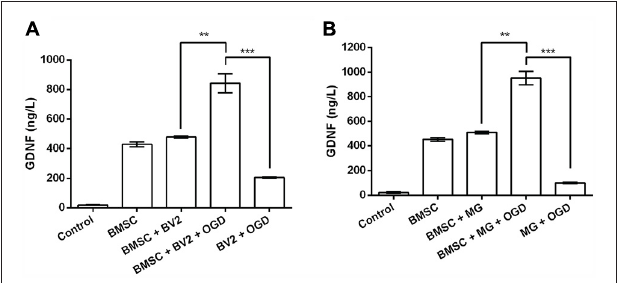
FIGURE 1 | Conditioned medium (CM) from cultures of oxygen-glucose deprivation (OGD) activated BV2 and microglia (MG) stimulates glial cell-derived neurotrophic factor (GDNF) production by bone marrow mesenchymal stem cells (BMSCs). (A) BV2 or (B) MG cells were exposed to OGD for 4 h before the addition of CM to BMSCs. After 24 h, GDNF concentrations in the BMSC culture supernatants were determined by ELISA. ∗∗ P < 0.01. ∗∗∗ P <